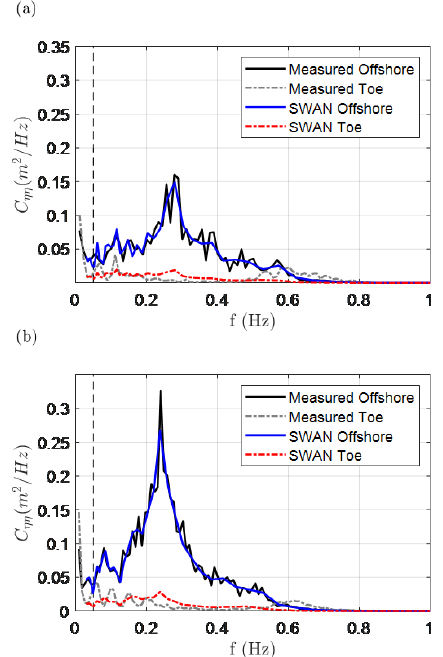
Figure B1. Comparison of observed and modelled wave spectra for (a) January 2015 and (b) January 2017. Dashed vertical lines sepa- rate SS and IG frequencies. (See Fig. 5 for reference to instrument